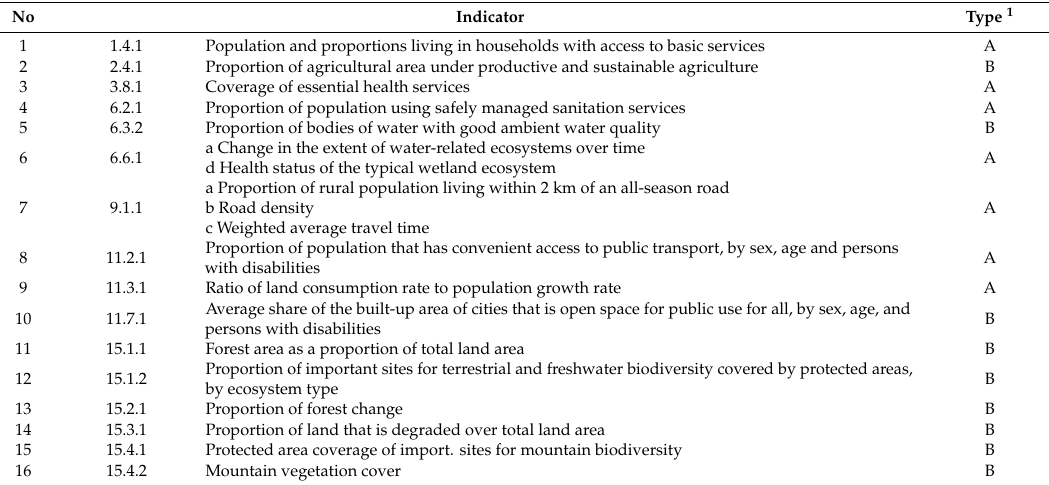
Table 2. The 16 indicators derived using geospatial data.